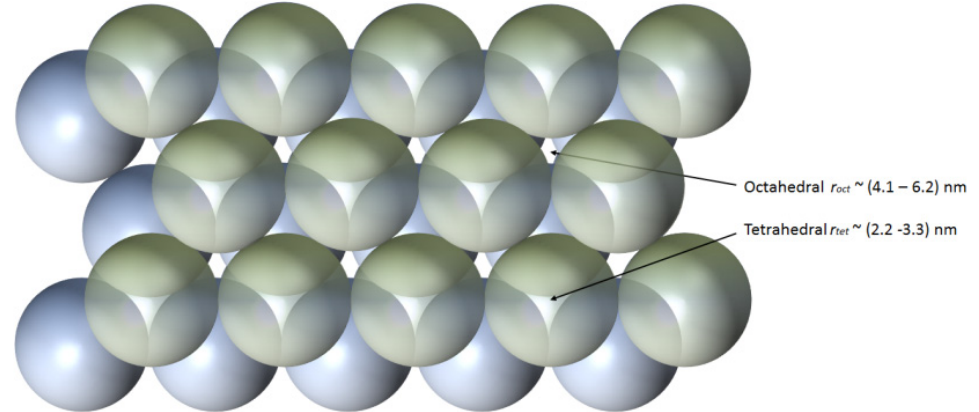
Figure 1. An illustration of hcp packing and the two types of interstitial regions. As an approximation a round sphere that can fit into the pores is often assumed to determine the size of a molecule that can percolate or diffuse into the structure. This does not, however, take into account irregular shapes and quantities of larger molecules, more typical of real situations. The site size distribution shown reflects that calculated from the bulk of the size distribution of the nanoparticles used in this work, measured by dynamic light scattering (DLS).